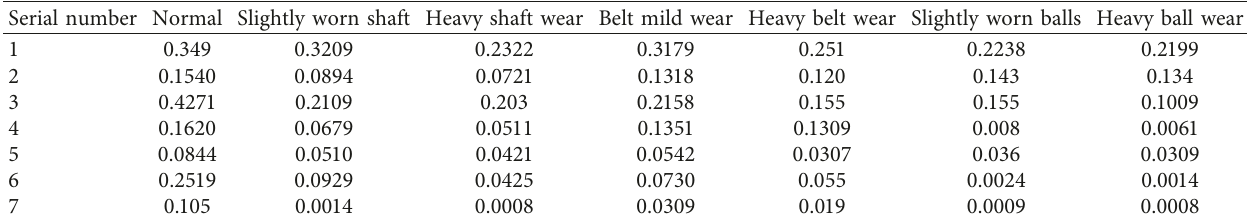
Table 5: Energy distribution of the second category (rotating shaft, belt, and ball) example failure mode.